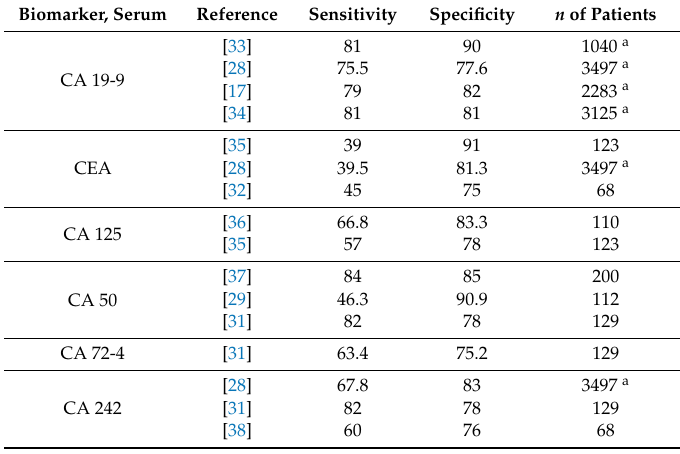
Table 1. Summary of diagnostic sensitivity and specificity of carbohydrate biomarkers for Pancreatic ductal adenocarcinoma